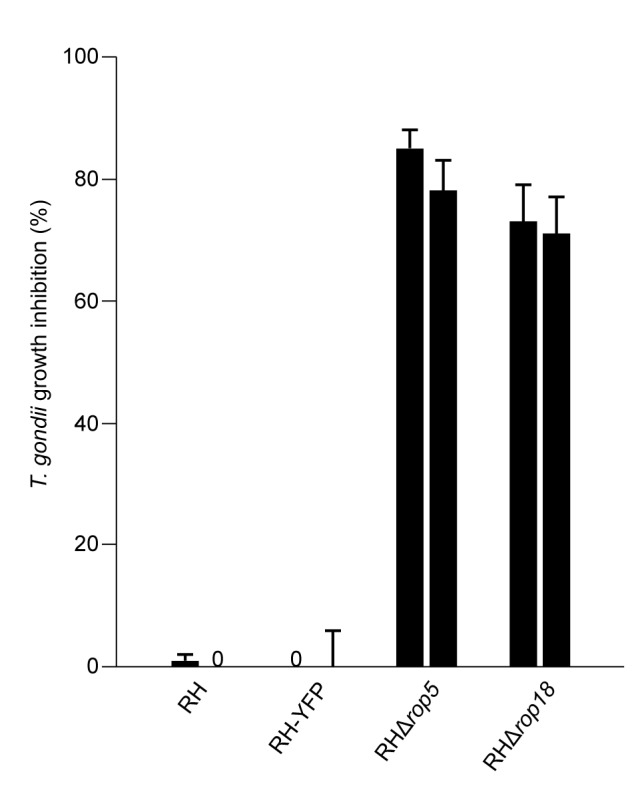
Inhibition of T. gondii growth in fibroblasts by IFNγ.C57BL/6 strain mouse embryonic fibroblasts were induced for 24 h with 10 U ml−1 IFNγ and infected with RH, RH-YFP, RHΔrop5, or RHΔrop18 at an MOI of 0.3. After 24 h, 3H-uracil was added and the assay harvested after a further 24 h culture. Growth inhibition was calculated as in Materials and Methods relative to parallel cultures of similarly infected cells not induced with IFNγ. Growth of the RHΔrop5 and RHΔrop18 parasites was massively inhibited, while RH and RH-YFP were completely insensitive to growth inhibition. Error bars represent the standard deviations of 3H-uracil incorporation from triplicate cultures.